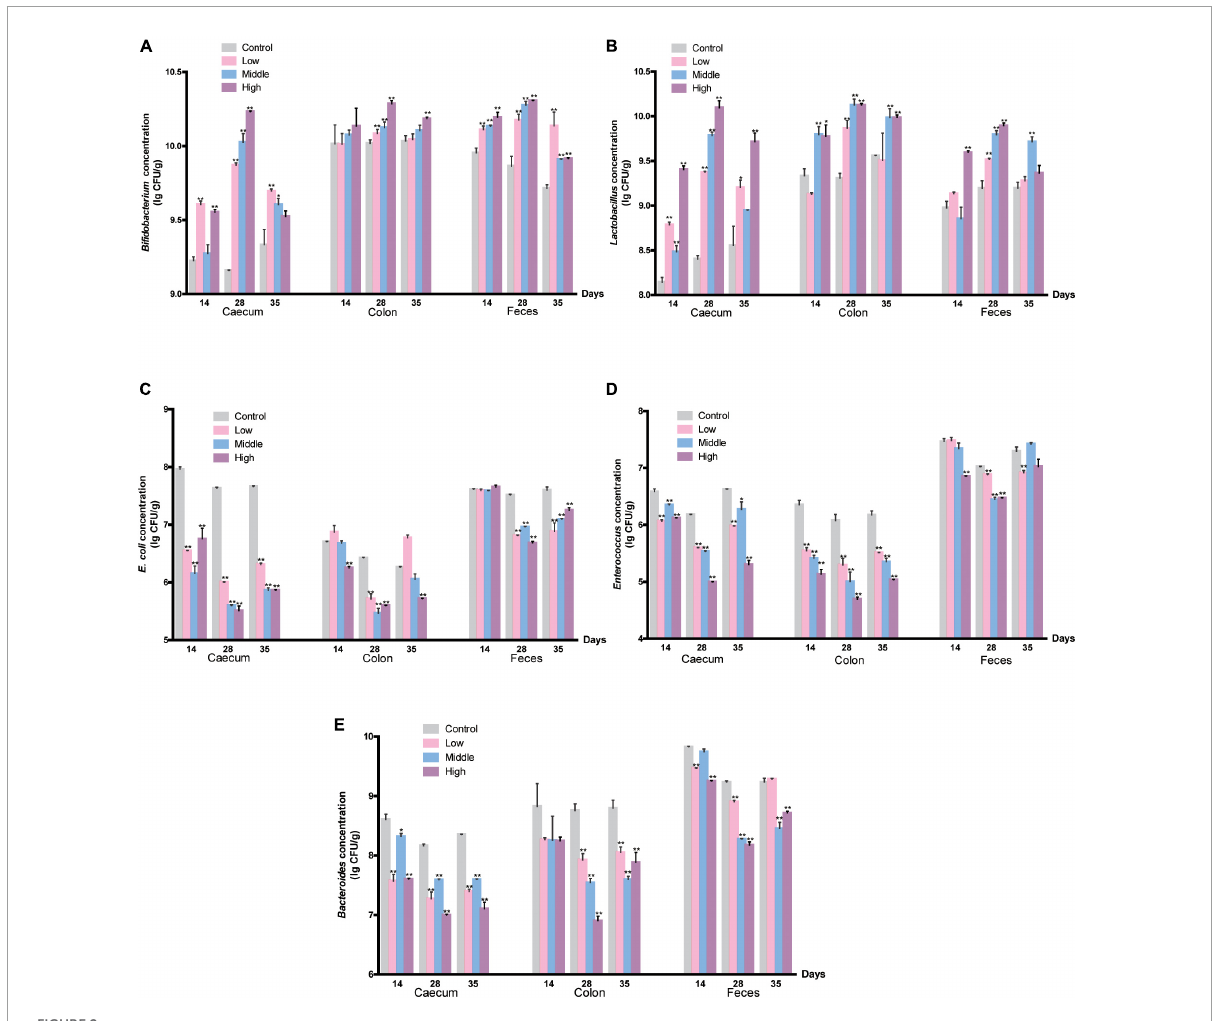
FIGURE2 The amount of intestinal bacteria. (A) Bifidobacterium ; (B) Lactobacillus ; (C) E. coli ; (D) Enterococcus ; (E) Bacteroides . Data are presented as mean ± SD ( n = 10 for each group). *P < 0.05, and **P < 0.01 represent a significant difference from the control